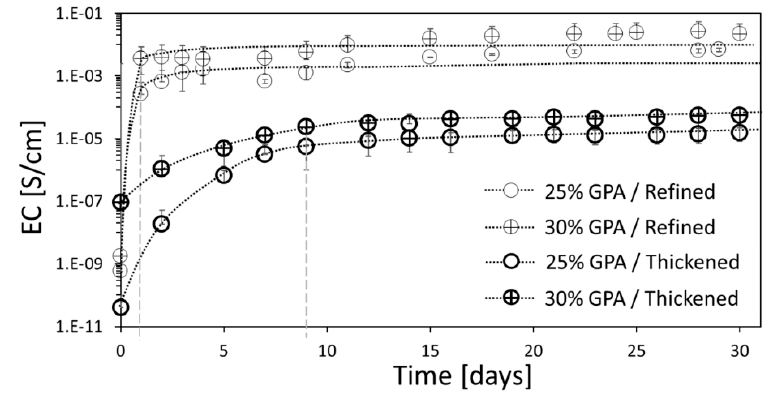
Figure 3. Temporal electrical conductivity (EC) of refined and thickened linseed oils loaded with